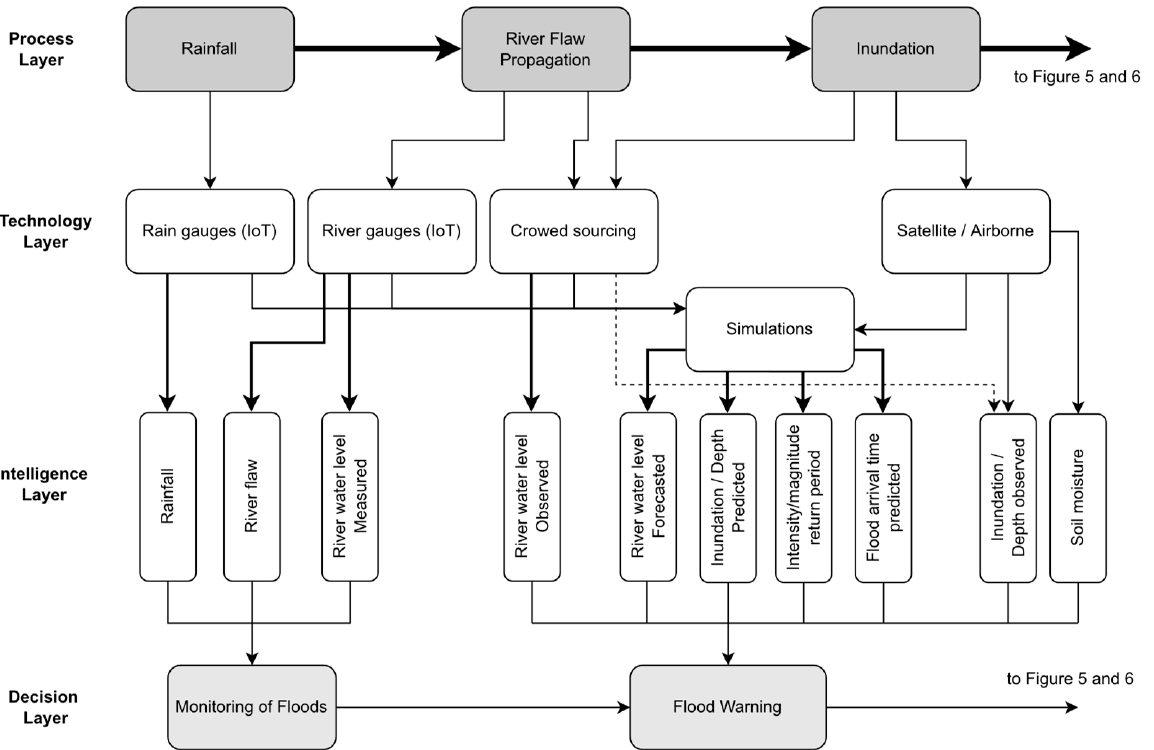
Figure 4. Intelligence required for monitoring emerging flood situations.